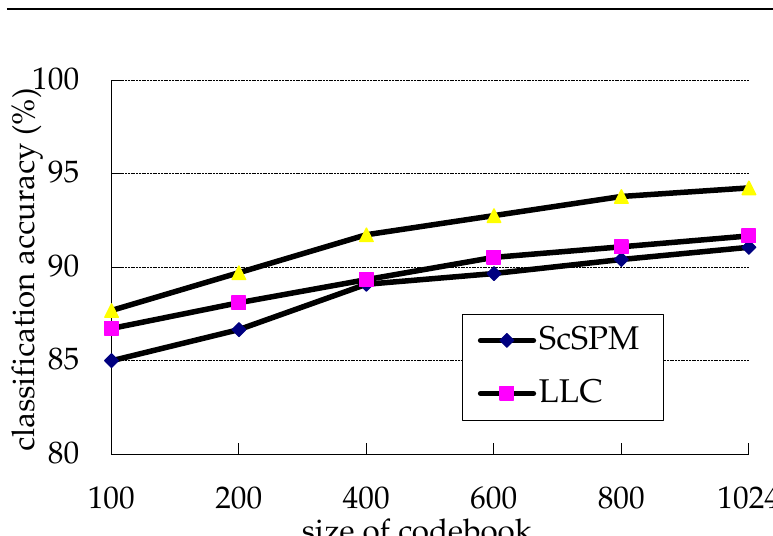
Figure 4. Curves of classification results of different codebook dimensions of the three different methods. Table 2. MSTAR classification results (%).